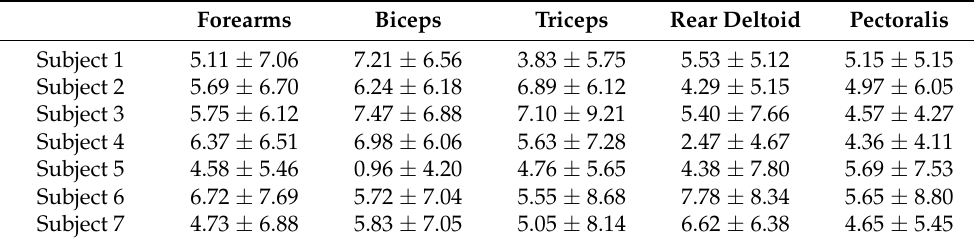
Table 2. Mean and standard deviation of the absolute error between measured EMG values and proposed model estimated values. The unit is %MVC.